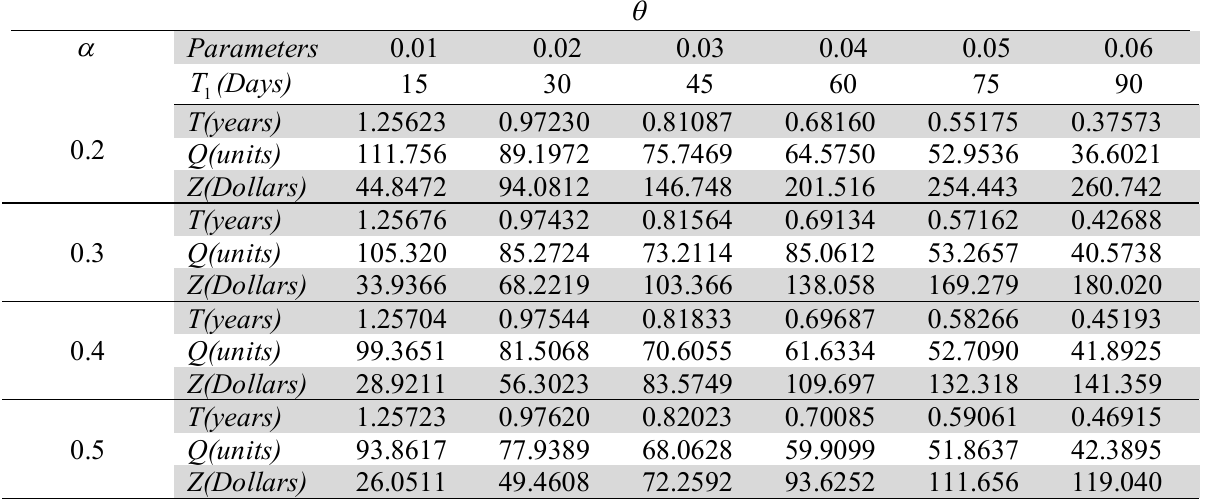
The results of optimal solution for different values of